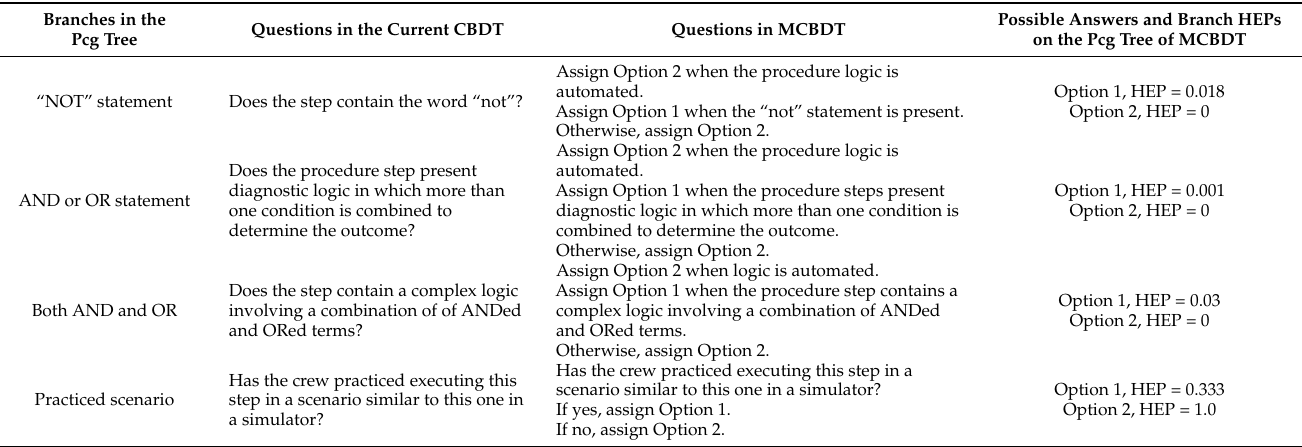
Table 5. Modified guide for Pcg decision tree